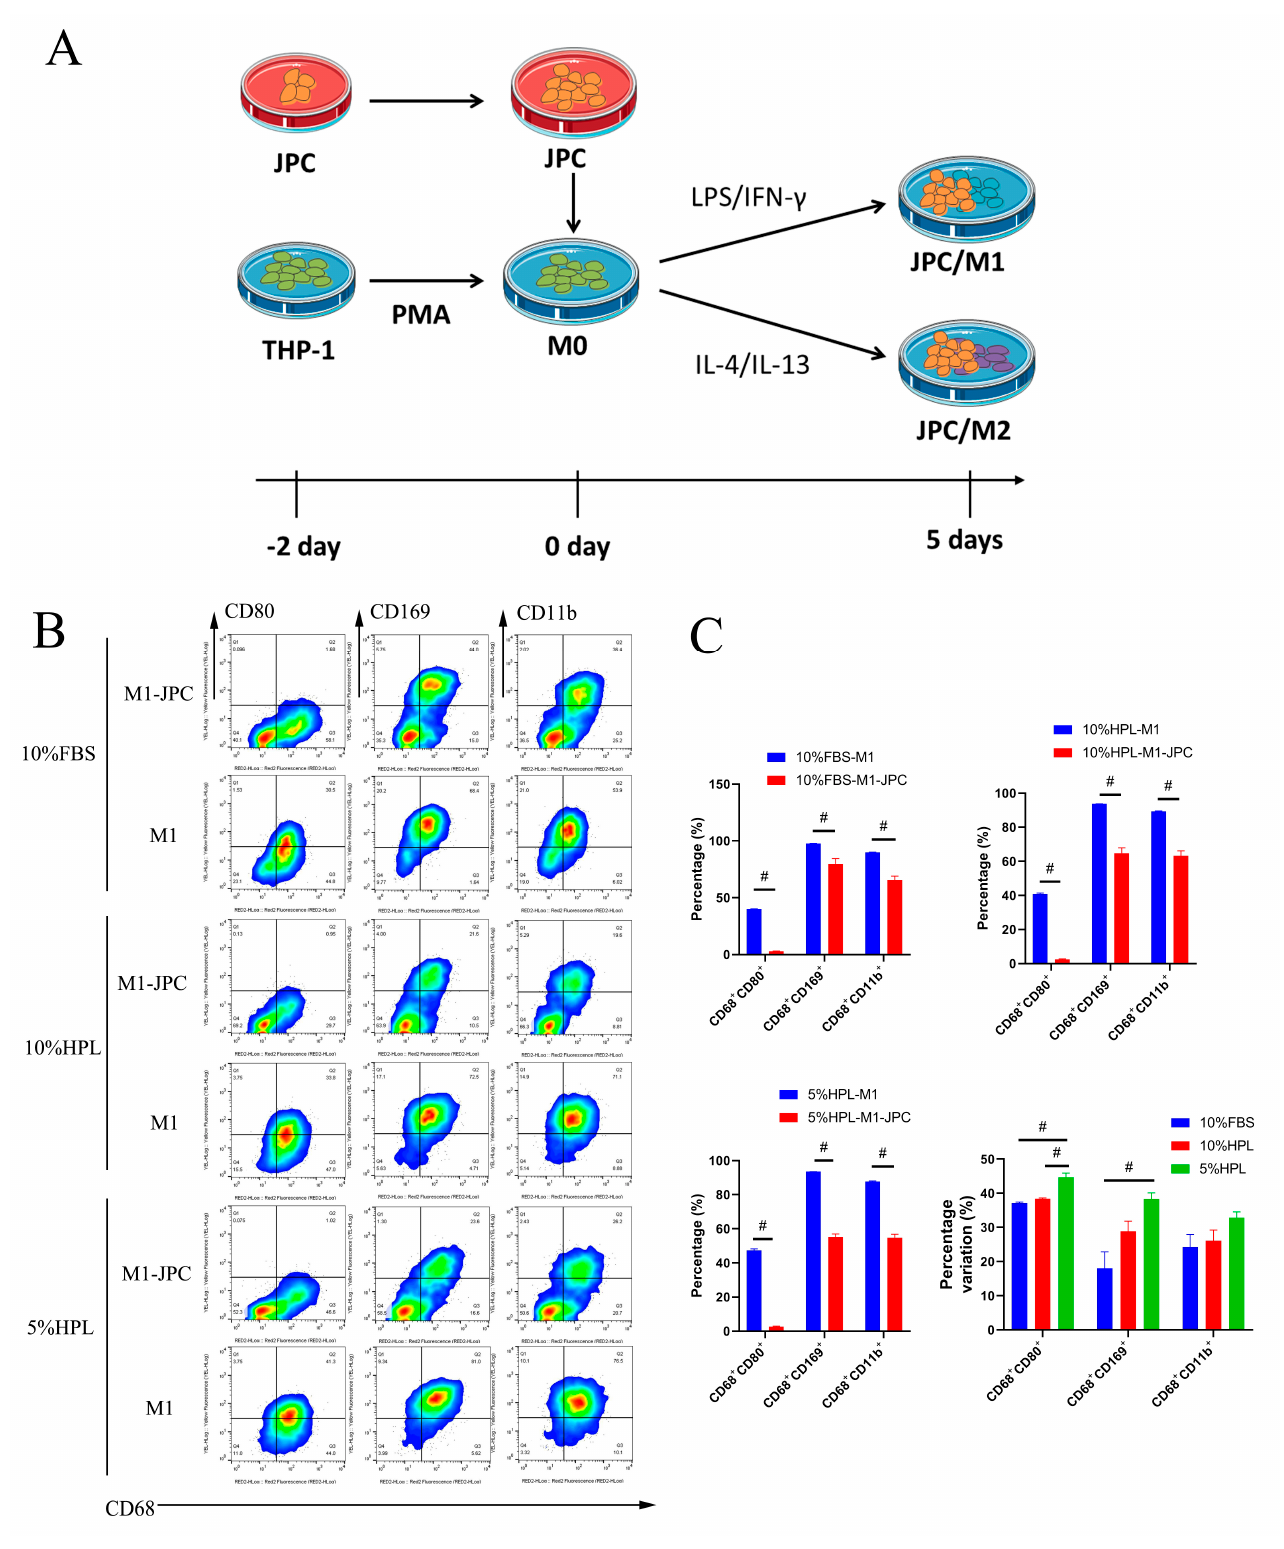
Figure 5. Surface marker expression by M1 macrophages after direct coculture with JPCs under FBS or hPL culture supplementation. ( A ) Schematic diagram of the experimental procedure for the contact coculture experiment of JPCs and macrophages. ( B ) Representative flow cytometric dot plots for CD80, CD169, and CD11b expressions in CD68 + macrophages in monocultures (M1) and cocultures (M1-JPC). ( C ) Percentages of CD80, CD169, and CD11b expressions and percentage variation in monocultures (M1) and cocultures (M1-JPC), depending on the used culture supplementations ( n = 3, # p <